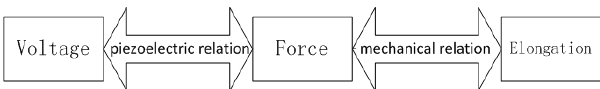
Figure 4. Internal relations of the piezoelectric actuator (no se- quence between these two